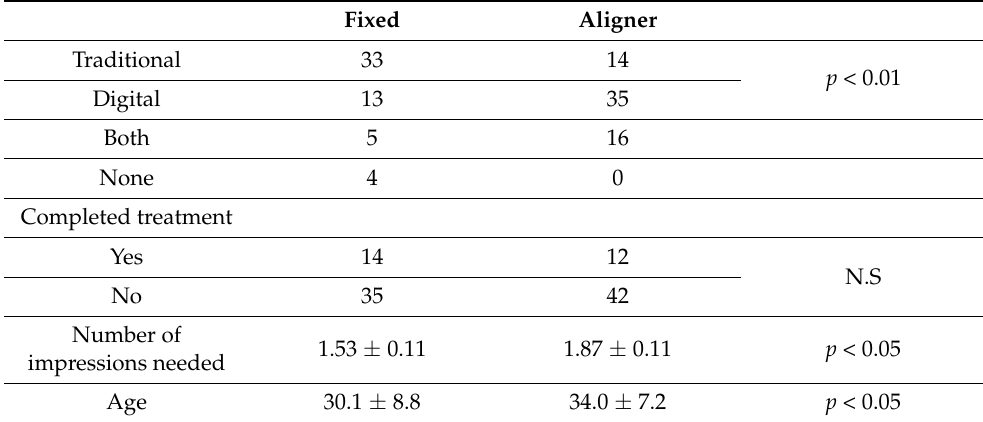
Table 2. Comparison between fixed devices and